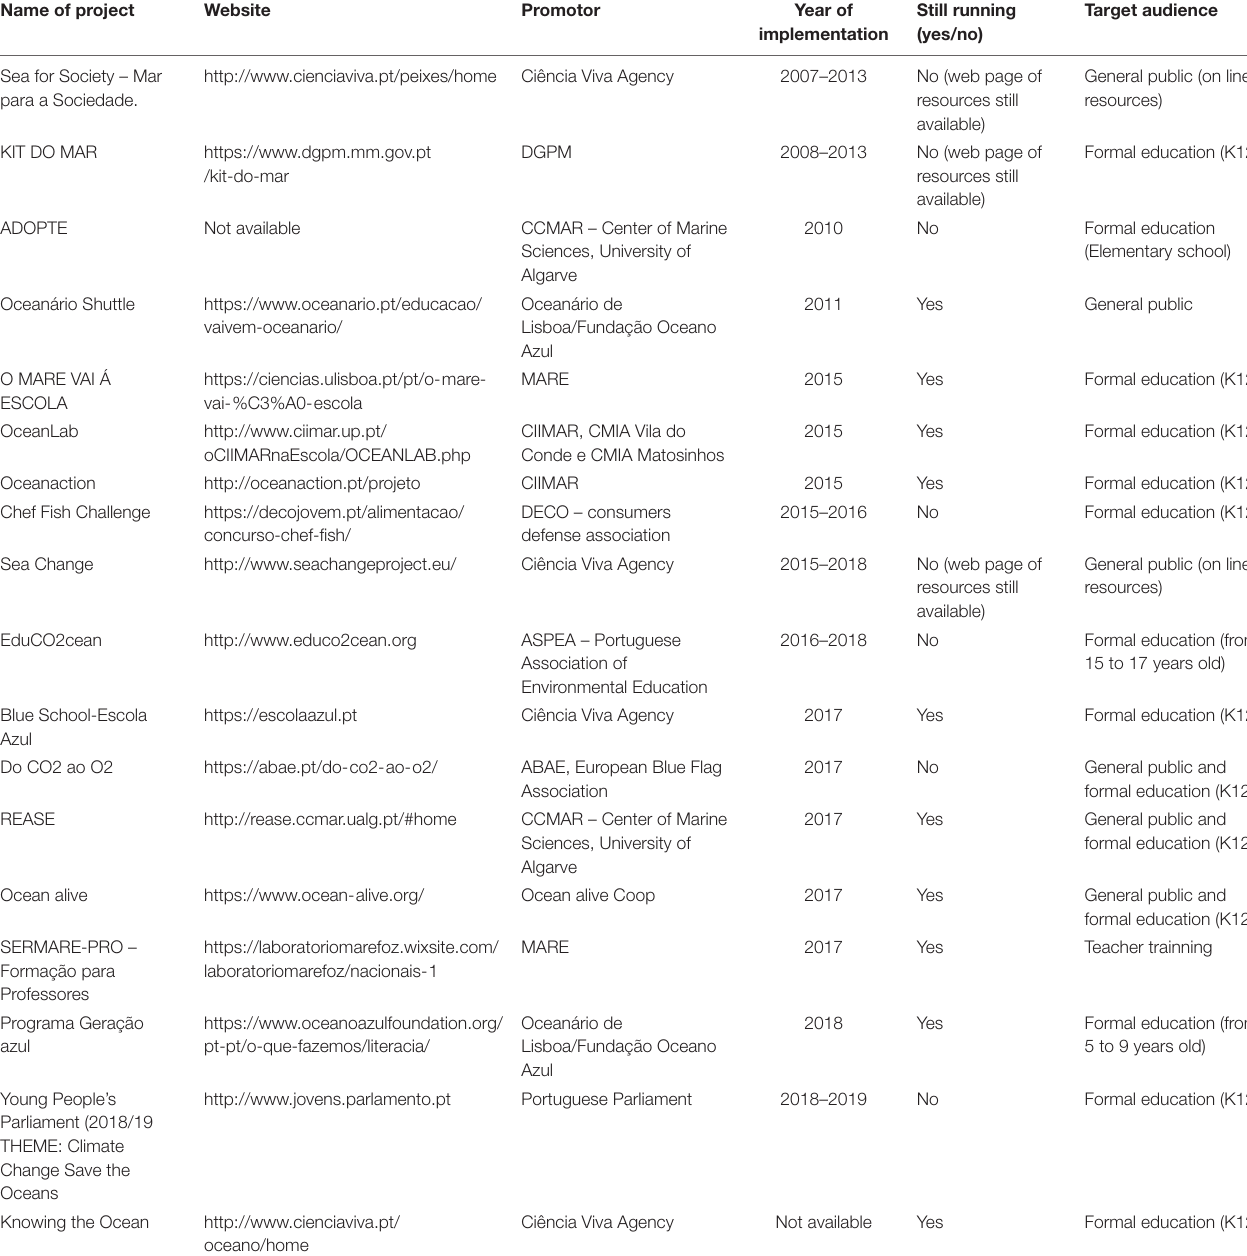
TABLE 1 | Past and present ocean literacy education projects developed in